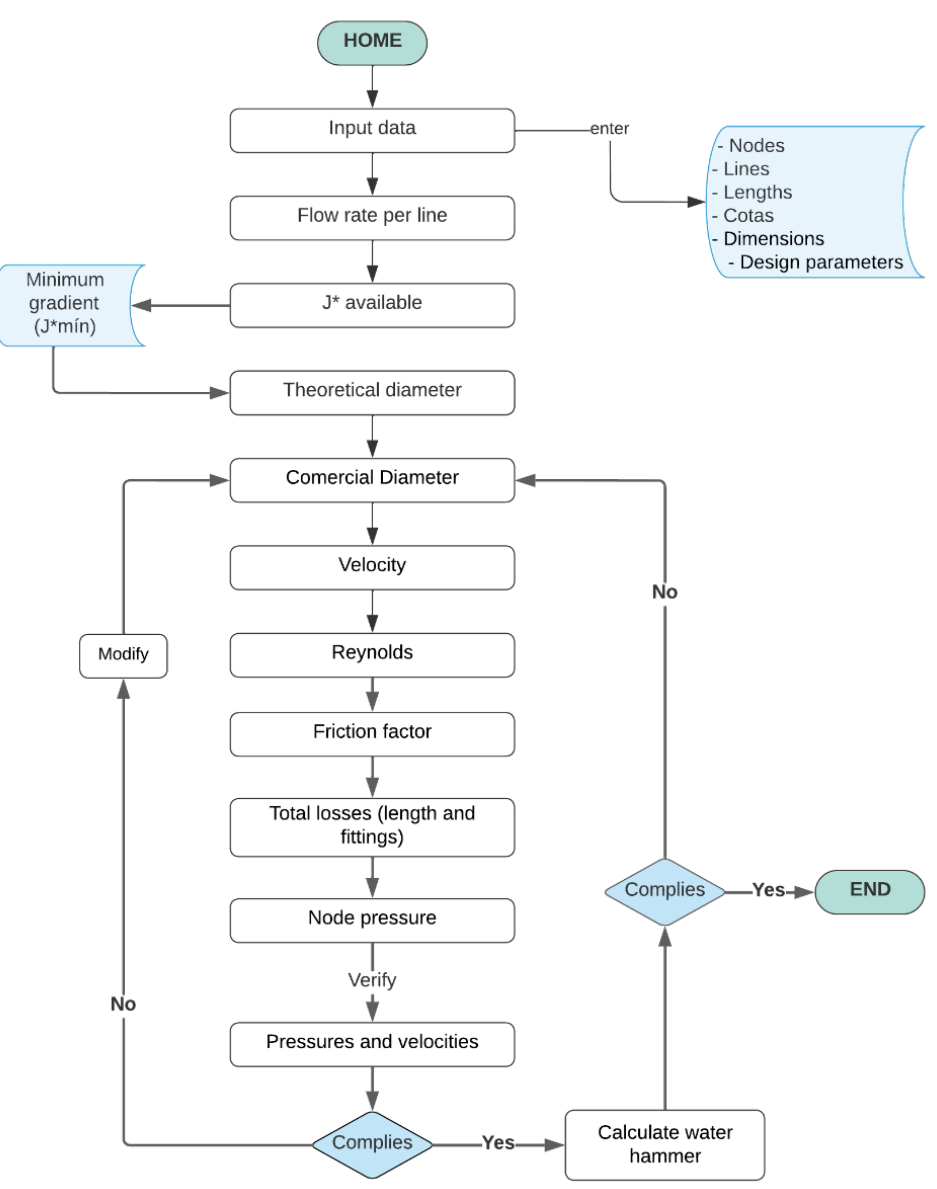
Figure 5. Flowchart of the hydraulic gradient method.